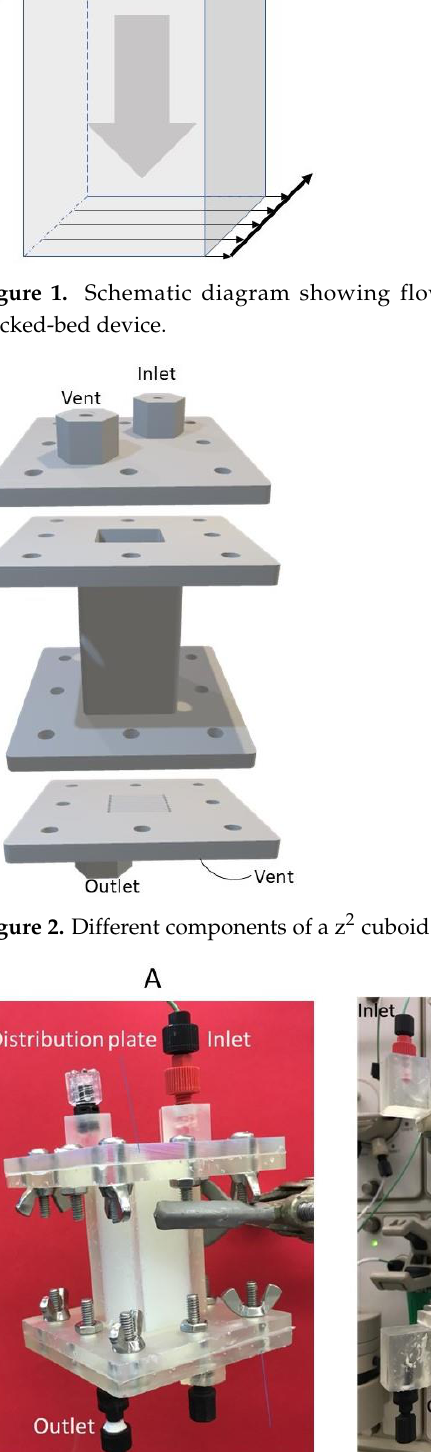
Figure 3. ( A ) Photograph of the 24 mL z 2 cuboid SEC device used in this study. ( B ) Photograph of the 200 mL z 2 cuboid SEC device used in this study. 2.4. Size-Exclusion Chromatography Experiments Size-exclusion chromatography experiments were carried out with mixtures of model proteins (BSA and lysozyme) as feed solution. The experiments with the 25 mL devices (i.e., the conventional and short and wide columns, and the 24 mL z 2 cuboid SEC